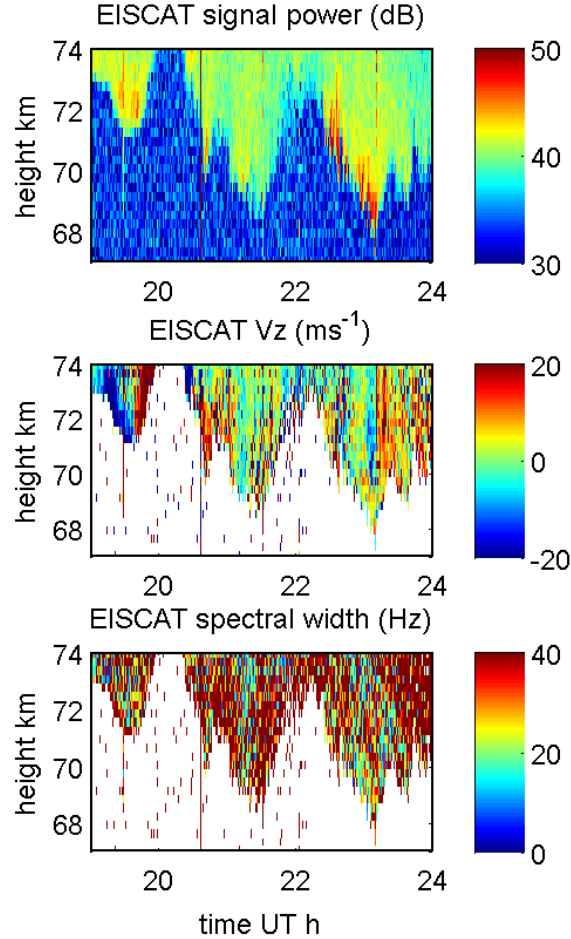
Fig. 5. EISCAT observations covering the strong PMWE event in the evening sector. Upper panel shows radar echo strength, middle panel shows echo Doppler shift (positive towards the radar), lower panel shows echo spectral width (all 30s integrated